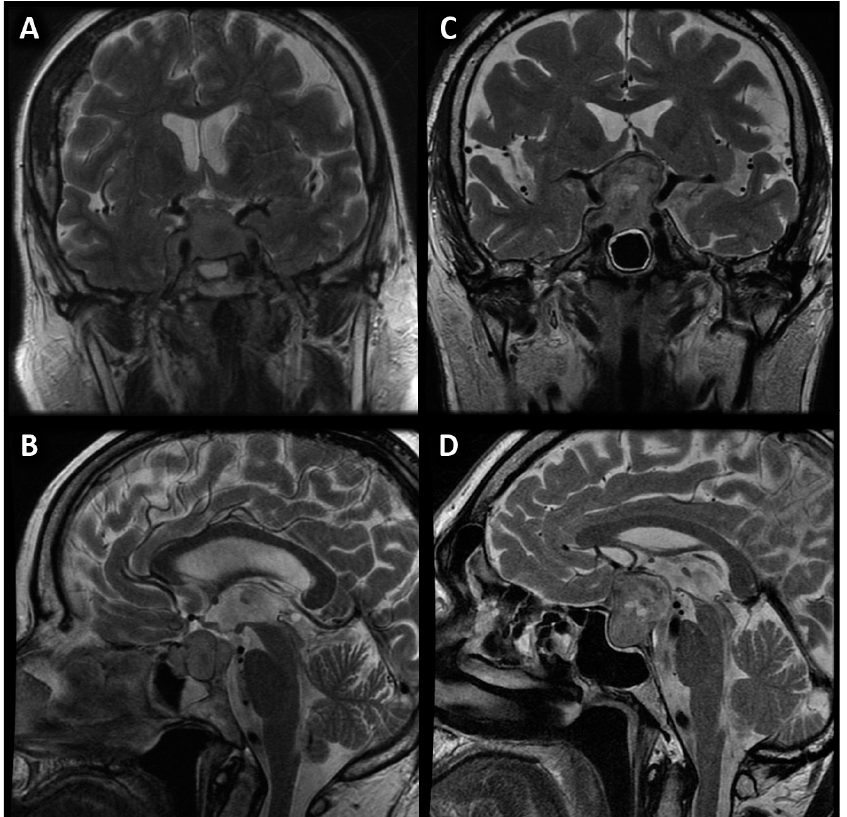
Figure 1. Coronal ( A ) and sagi tt al ( B ) image of sellar meningioma compared with coronal ( C ) and sagi tt al ( D ) image of pituitary macroadenoma with suprasellar extension and cystic parts. sagittal ( D ) image of pituitary macroadenoma with suprasellar extension and cystic